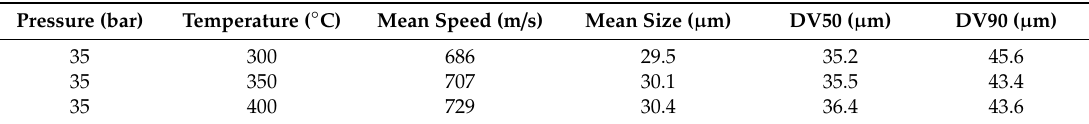
Table 2. Particle sizes measured with HW CS2 using pressure of 35 bar and gas temperatures